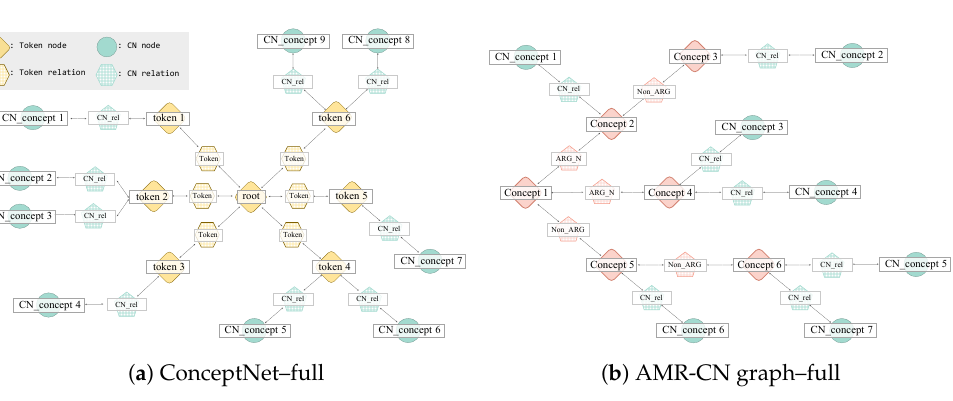
Figure 4. ConceptNet-Full graph ( a ) expands ConceptNet based on all words in the question. AMR- CN-Full graph ( b ) expands all the concepts in the AMR graph with ConceptNet